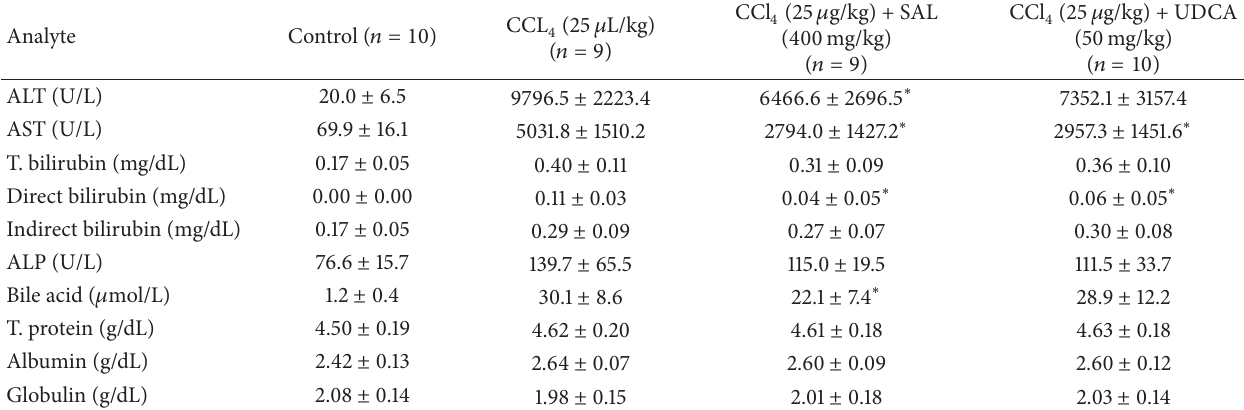
Table 4: Effect of SAL (400mg/kg) on the major biomarkers of liver in CCl 4 model. Analyte